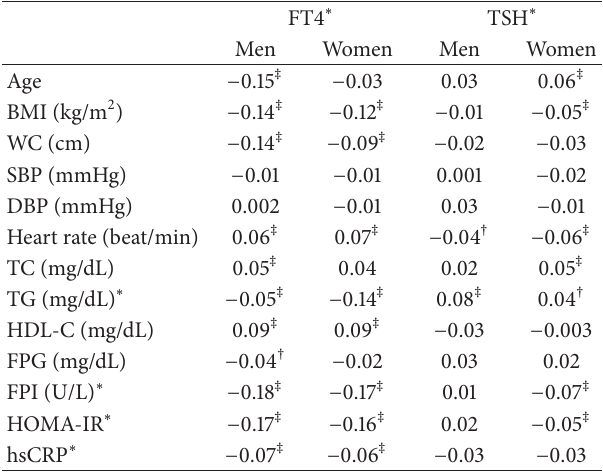
Table 2: Age-adjusted Pearson’s correlation coefficients of FT4 and TSH with clinical